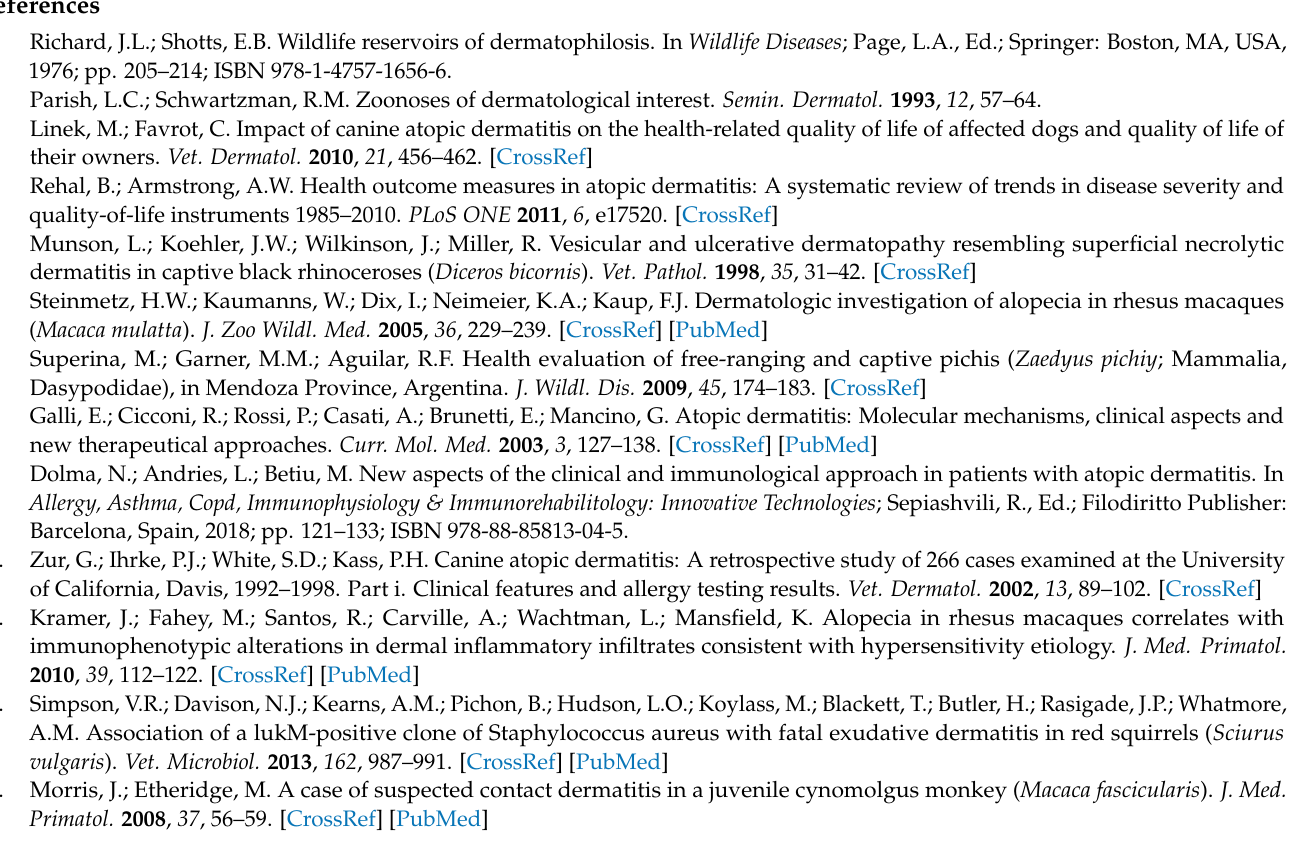
Table S3: All individually reported dermatitis cases for each order not presented in the synthesis, Table S4: Etiological agents responsible for the causes of dermatitis across mammalian wildlife species, Table S5: Each reported threatened species dermatitis cases and their corresponding IUCN (2021) threatened categories, concurrent disease, dermatitis treatment, and whether the treatment resolved